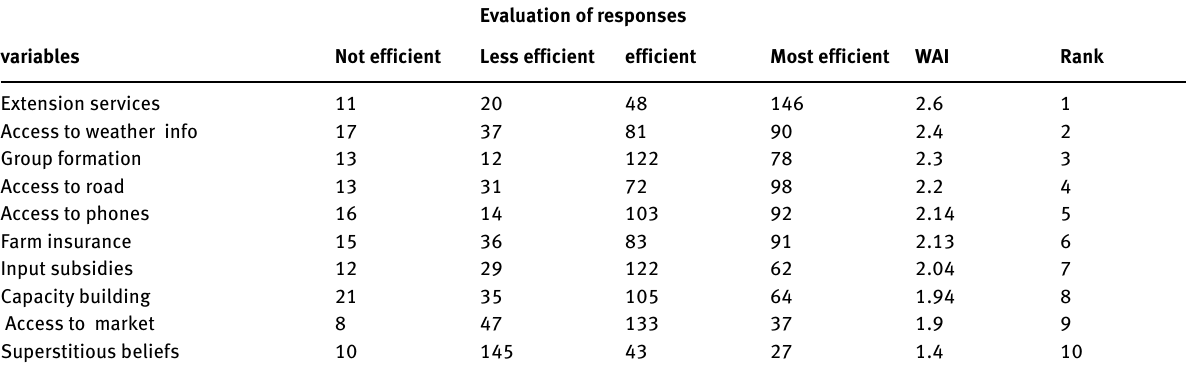
Table 4: Factors influencing climate change